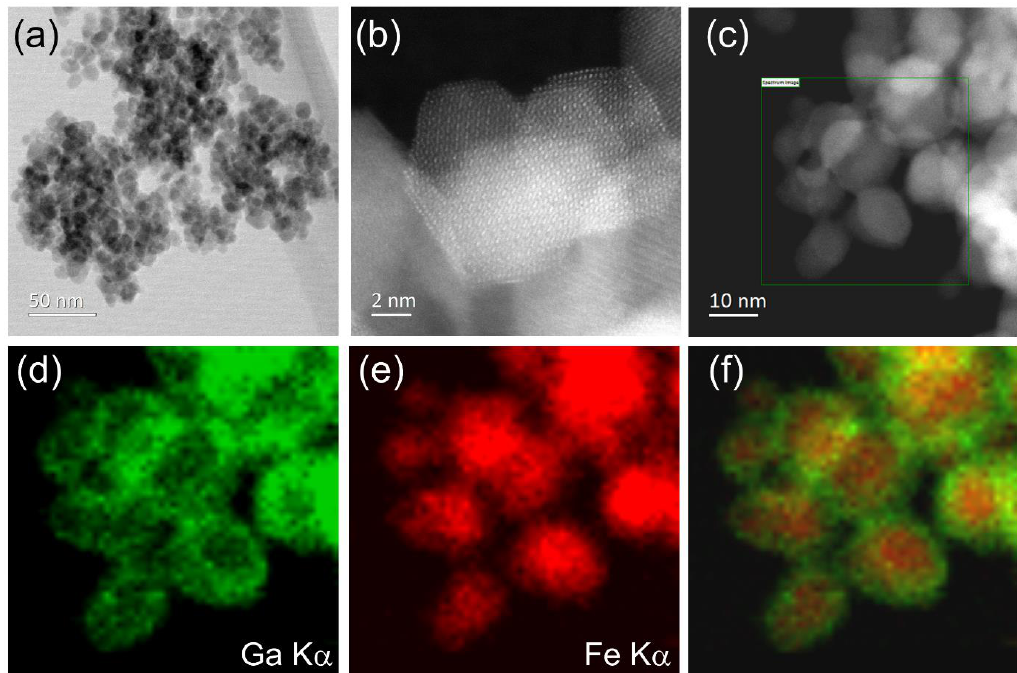
Figure 6. TEM of spinel phase with 1:1 Fe:Ga ratio. ( a ) Shows low magnification view, ( b ) higher magnification image, ( c ) region of elemental analysis, ( d ) EDS map for Ga, ( e ) EDS map for Fe and ( f ) composite elemental map. The box in ( c ) represents the regions studied in ( d – f ). Magnetisation measurements M vs T of Fe substituted -Ga 2 O 3 samples are shown in Figure 7. For the zero-field cooling, the samples were first measured in zero-field from room temperature down to 4.2 K (ZFC), after a field of 100 Oe was applied, and sample temperature increased to 300 K. After this process, samples were cooled and measured again down to 4.2 K under the applied field (FC). Comparing the magnetisation curves of both samples Fe:Ga with a ratio 1:1 as shown in Figure 8a, and 3:7 as shown in Figure 8b, we note superparamagnetic behaviour for both samples in the upper temperature range revealing blocking temperatures of about 115 and 155 K, respectively.